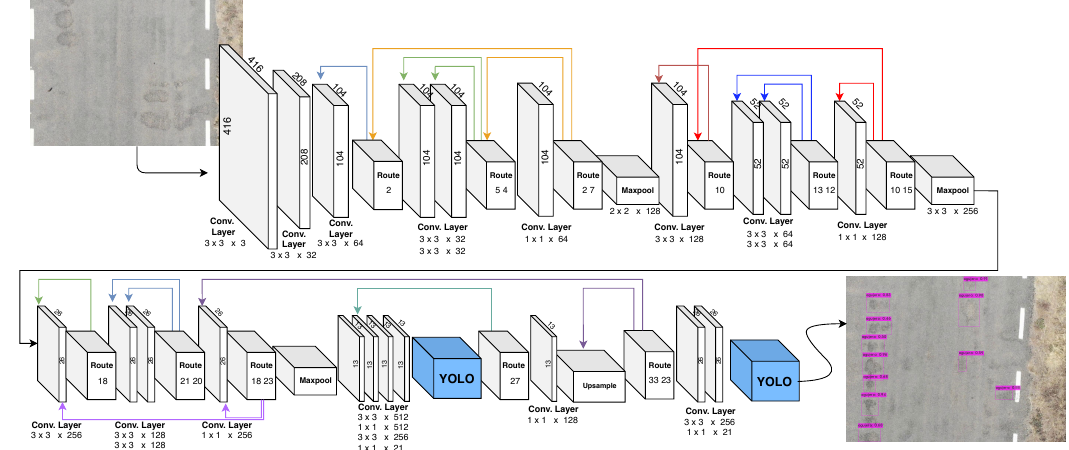
Figure 5. The network structure of the YOLOv4 pothole detection